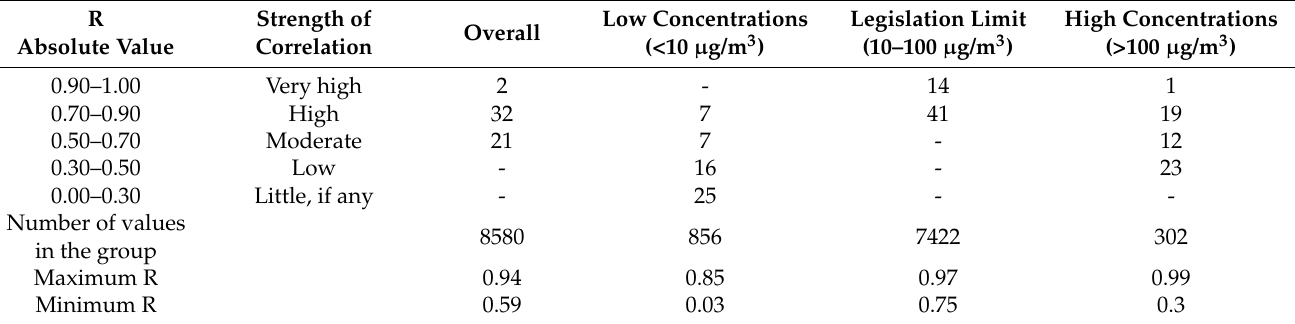
Table 5. Overview of correlation matrices among PM 10